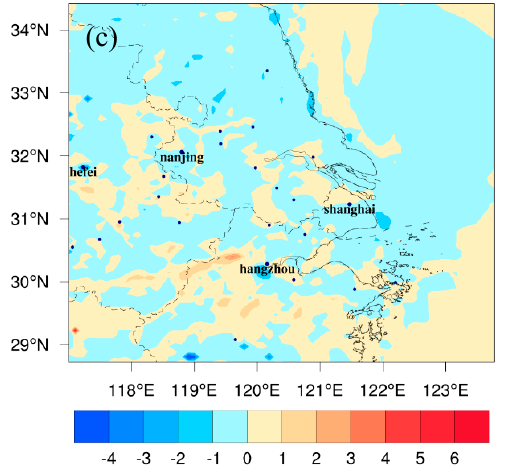
Figure 9. The spatial distribution of monthly averaged di ff erences of ( a ) Chem_O 3 , ( b ) Advt_O 3 , and ( c ) Vmix_O 3 between FUTMET and PREMET at night (from 19:00 to 06:00 LST). Chem_O 3 represents the O 3 chemical production process. Vmix_O 3 means the contribution of vertical mixing and dry deposition to O 3 . Advt_O 3 means the contribution of horizontal and vertical advections.